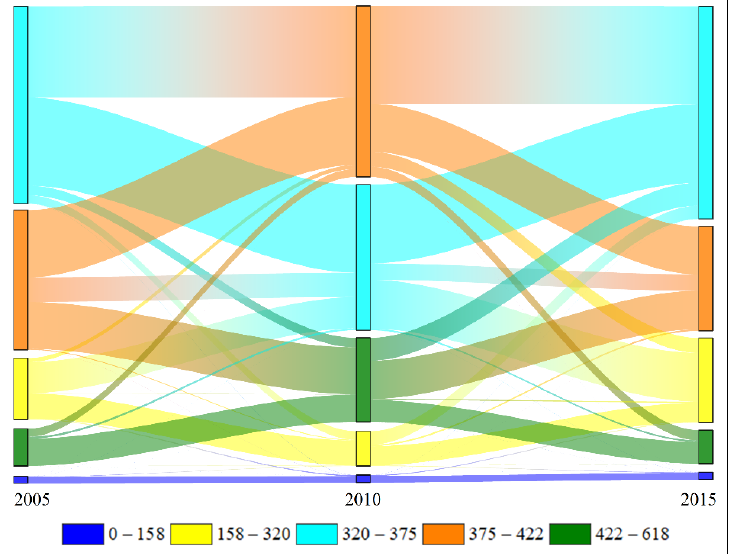
Figure 6. Sankey diagram of the area transfer matrix of different NPP levels in the NFB from 2005–2015. Table 6. Area transfer matrix of different NPP levels in the NFB from